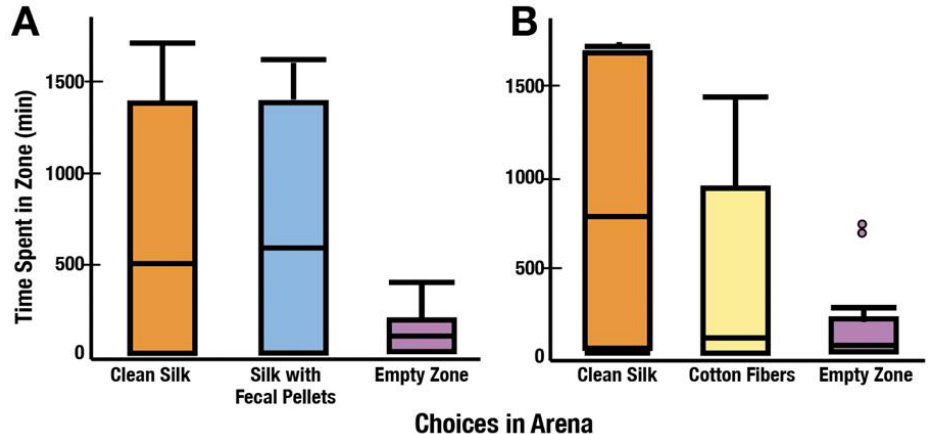
Figure 8. Amount of time, shown as box-and-whisker plots, that individual adult E. myersi spent in zones with different choices. ( A ) Zones included clean silk, silk with fecal pellets and two empty zones ( n = 10). ( B ) Zones contained cotton wool fibers, clean silk and two empty zones ( n = 9). Outliers are purple circles.